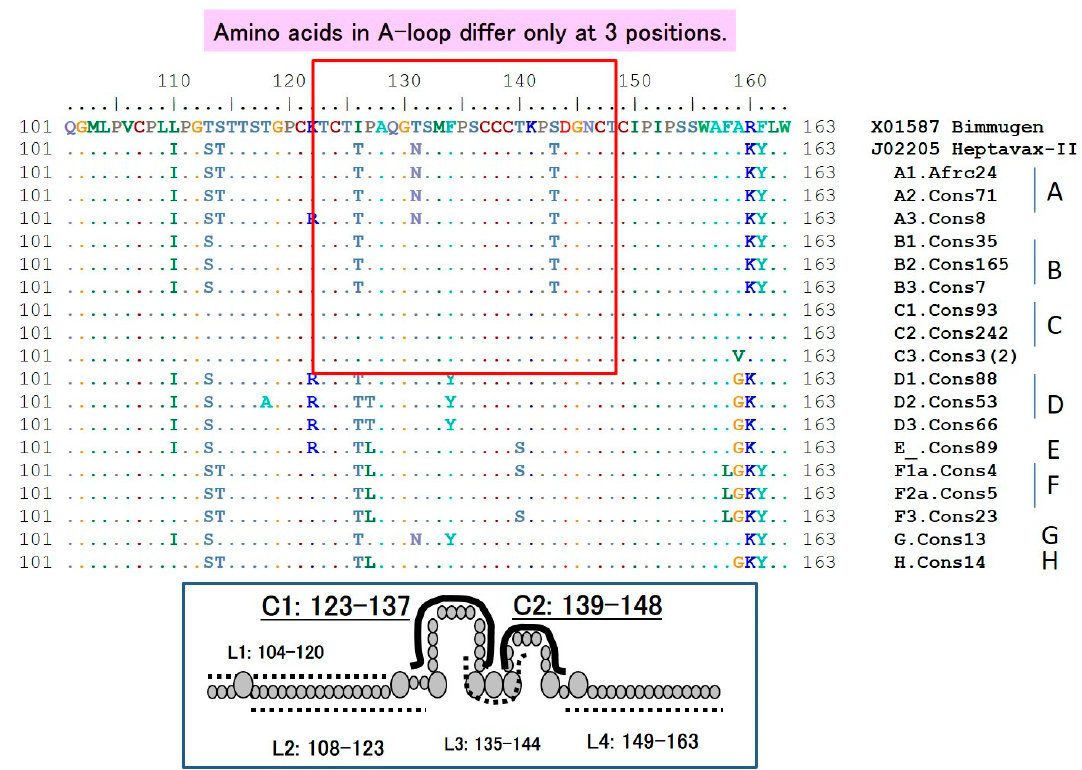
Figure 2. Sequence of the S-region “a” determinant. Neutralizing (protective) antibodies induced by vaccination target the conformational epitope of the “a” determinant, which is located in the S-region and retains many amino acids including Cys but with some mutations. The second hydrophilic loop (139 to 147 or 149 aa) is the major target for neutralizing anti-HBs produced following natural infection or vaccination. Abbreviations: Cys, cysteine; aa, amino acid; anti-HBs, hepatitis B surface